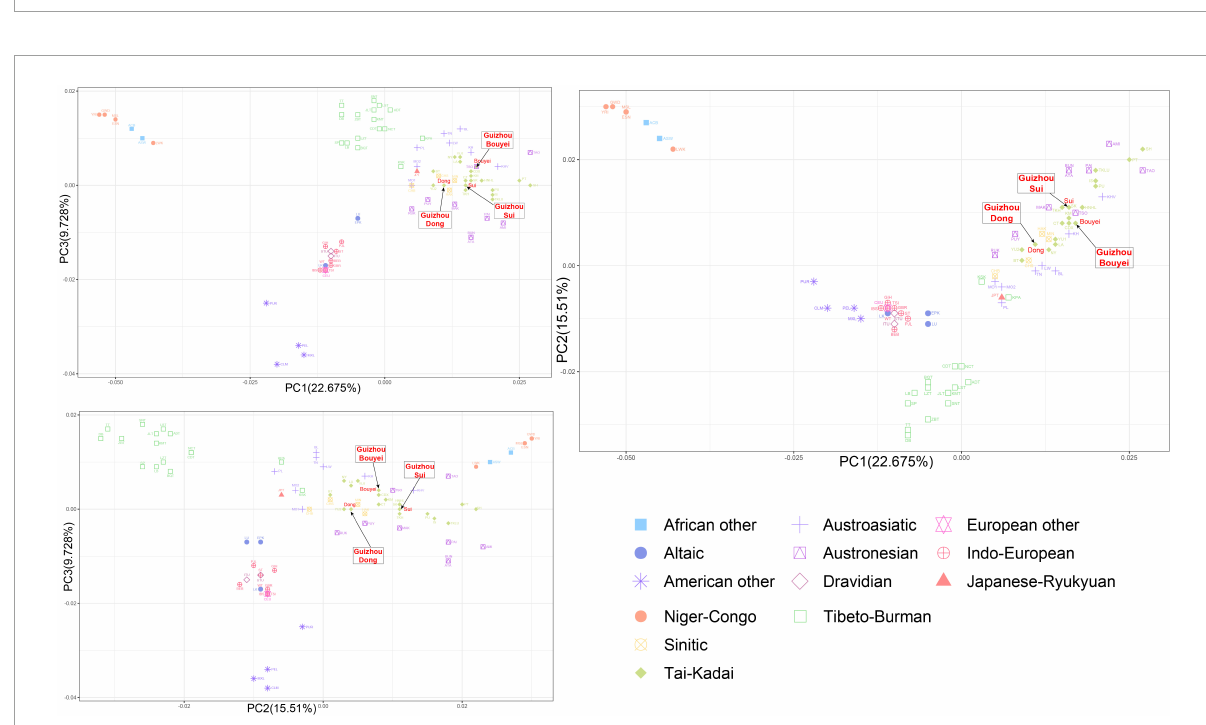
FIGURE6 The principal component analysis (PCA) plot for Tai-Kadai-speaking populations in Guizhou and 79 worldwide populations according geographic distributions. These three Guizhou Tai-Kadai-speaking populations belong to East Asian cluster, indicated in green. And point out the Sui, Bouyei, and Dong with arrows.